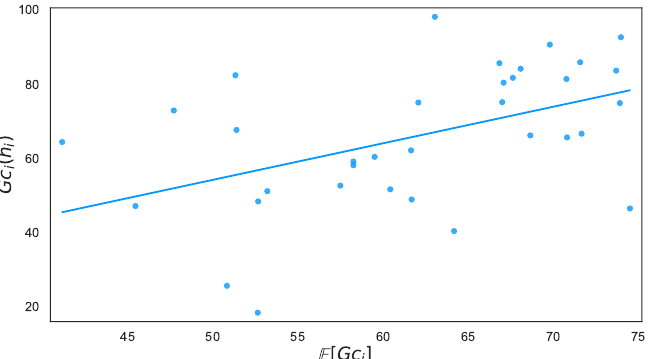
Figure 6. Random-Student’s Grades against Collaboration-group’s Grade Averages. r = 0.479, p = 0.004.